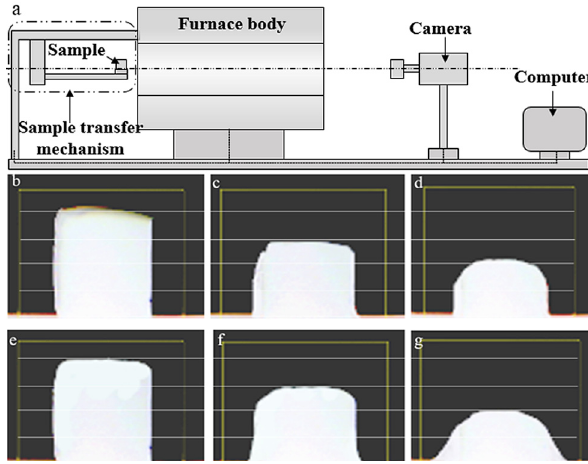
Figure 2: ( a ) Schematic diagram of the melting characteristic equipment type of CQKJ - II, ( b – d ) silhouette photographs of typical melting characteristics of original modi fi er, and ( e – g ) silhouette photographs of typical melting characteristics of new modi fi